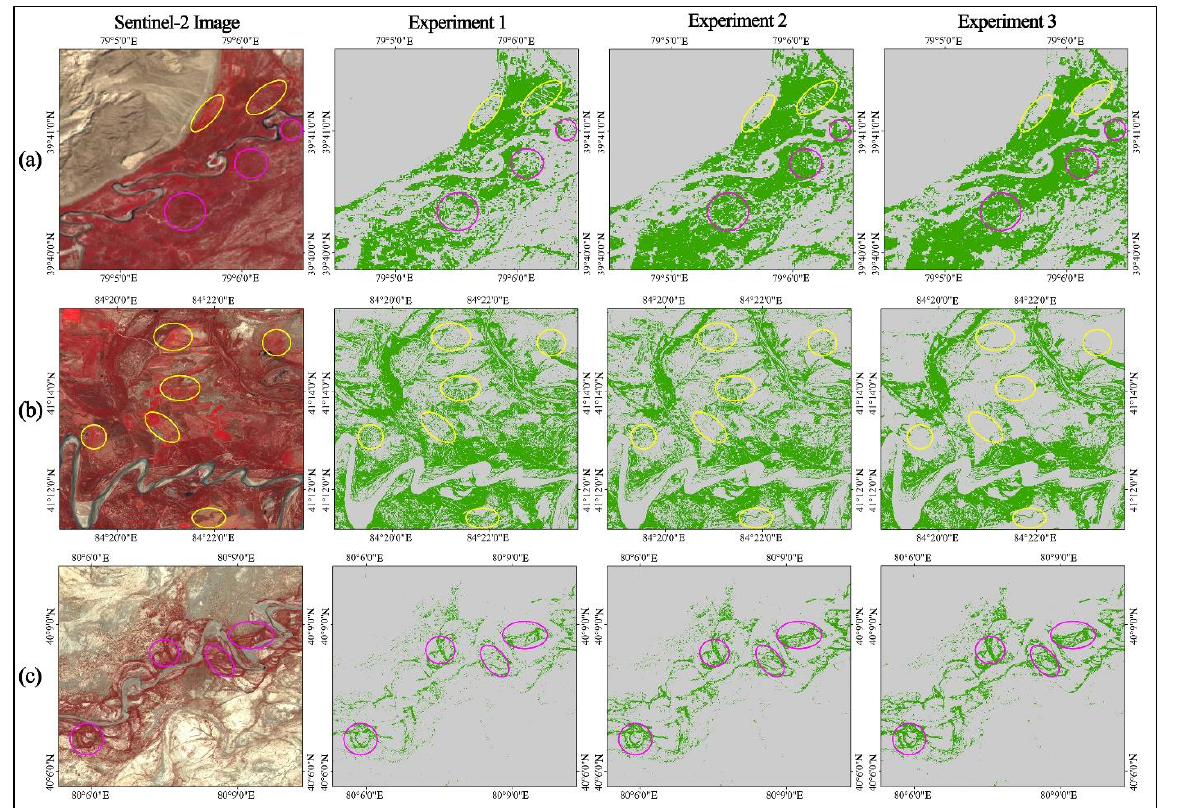
Figure 11. Detailed results for experiment one, experiment two, and experiment three for regions with fewer P. euphratica trees. ( a ) Results for the urban area; ( b ) results for vegetation in wetlands; ( c ) results for farmland.